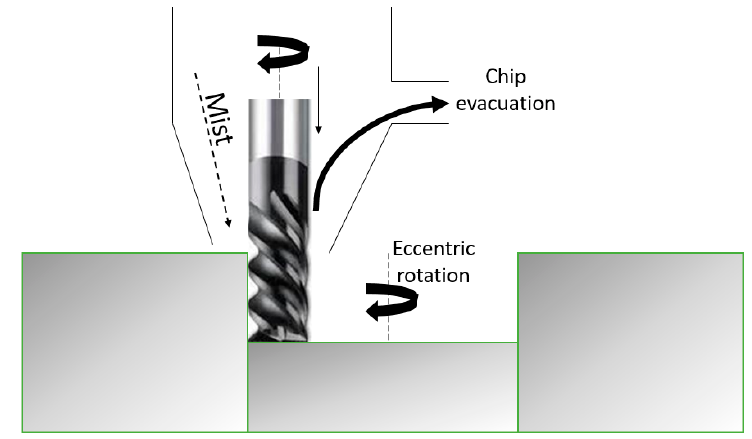
Figure 2. Schematic of the orbital drilling setup.